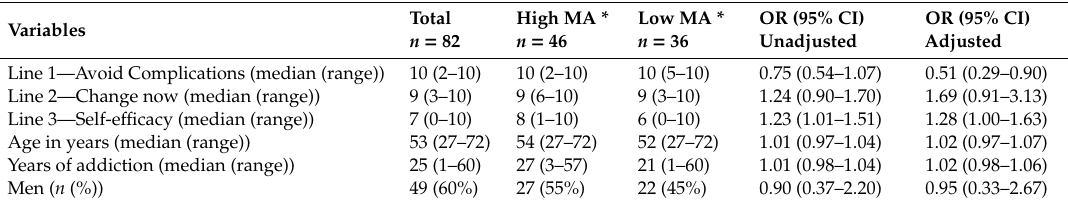
Table 2. Comparison of the characteristics of the groups with high and low meeting attendance. Variables